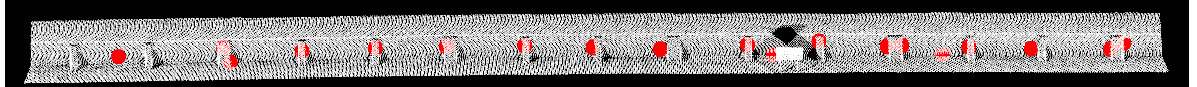
Figure 10. Keypoints sampling result